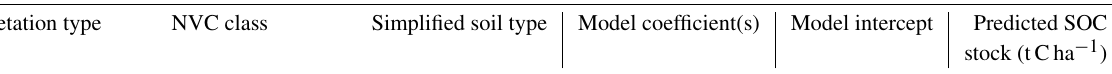
Table 4. SCSP tool lookup table based on models of surface SOC stock (tCha − 1 ; top 10cm of soil) prediction in Welsh salt marshes (using output of a subset of models from Table